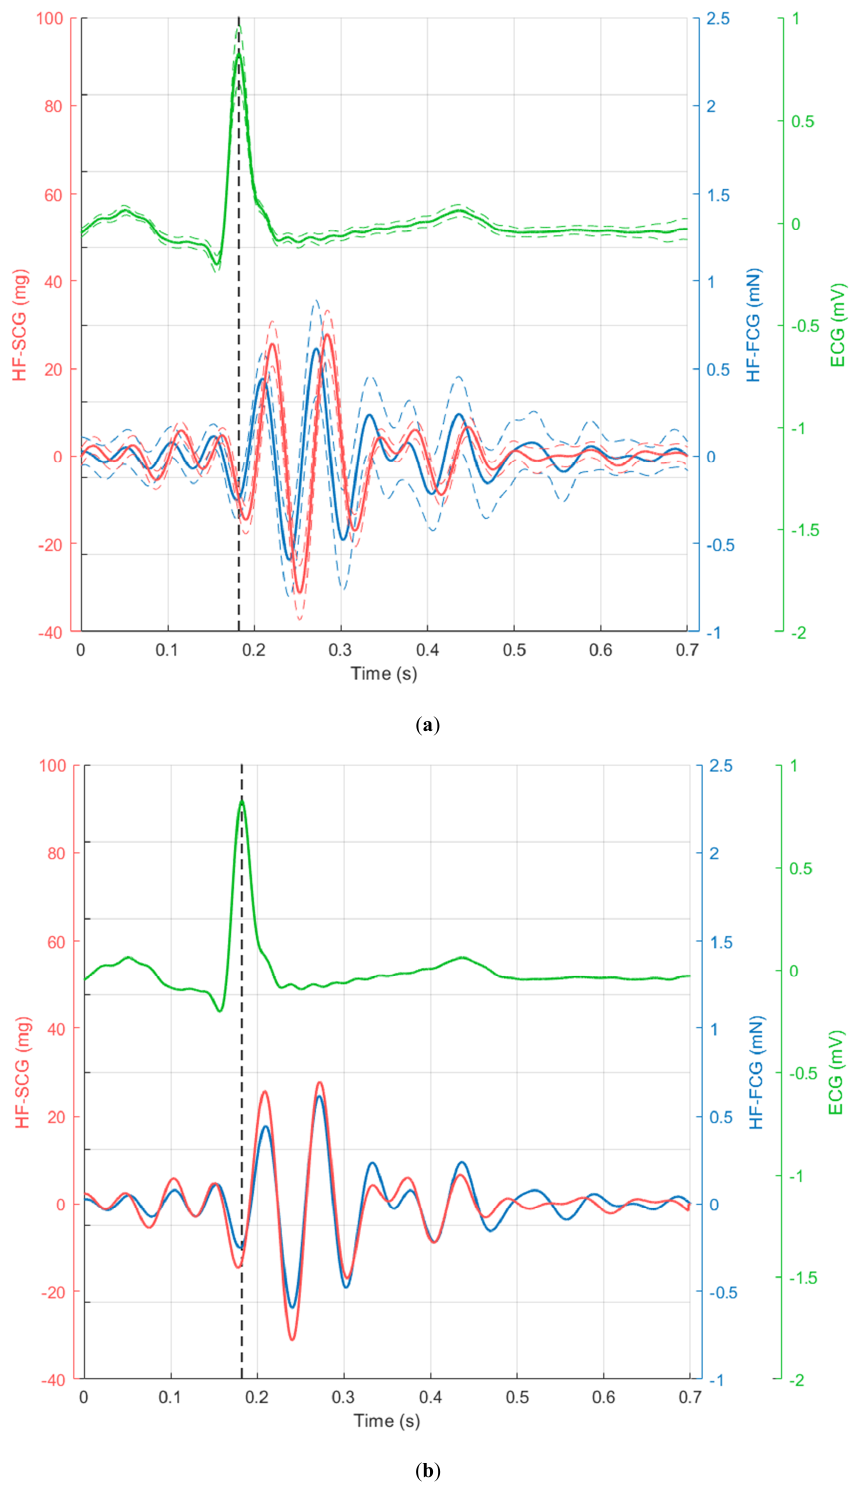
Figure 6. Subject #2 dataset. ( a ) ECG, HF-FCG and HF-SCG ensemble averages on 36 normal heartbeats (solid lines) with relative standard deviation (SD) intervals (dashed lines); ( b ) ensemble averages of ECG, HF-FCG and lag-compensated HF-SCG.